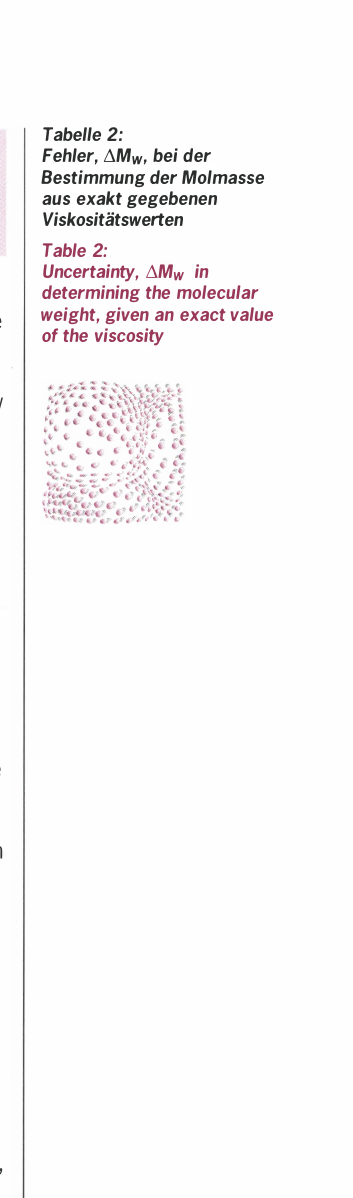
Tabel/e1: Abhiingigkeit einiger Mel3griil3en vom Table 1: Dependence of several measurable quantities on molecular weight, from reference [1]